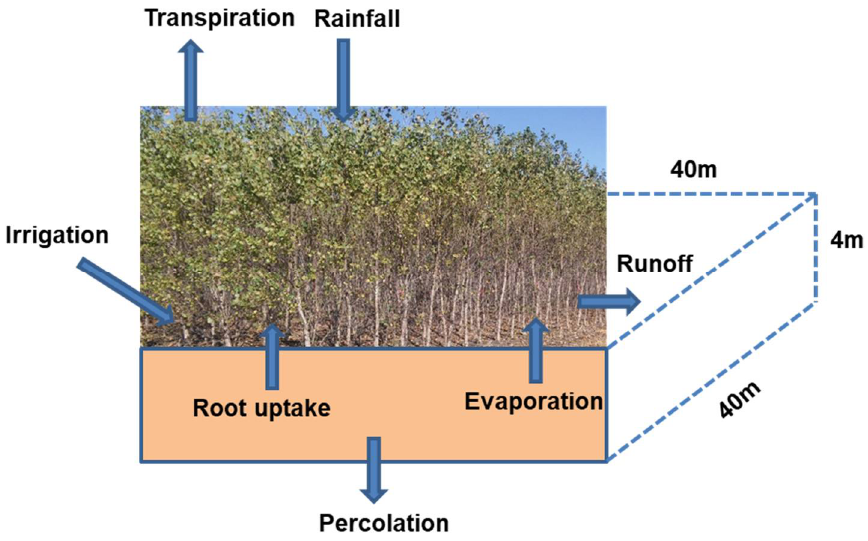
Figure 1. Schematic diagram showing the soil hydrological processes in a poplar plantation. Soil surface water runoff is estimated as